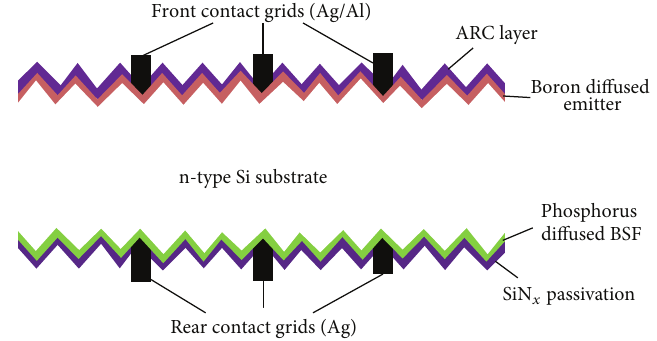
Figure 11: Schematic of Yingli’s PANDA solar cell